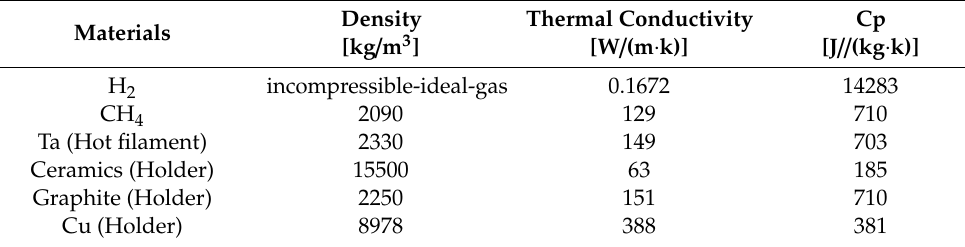
Table 1. The properties of the materials in the